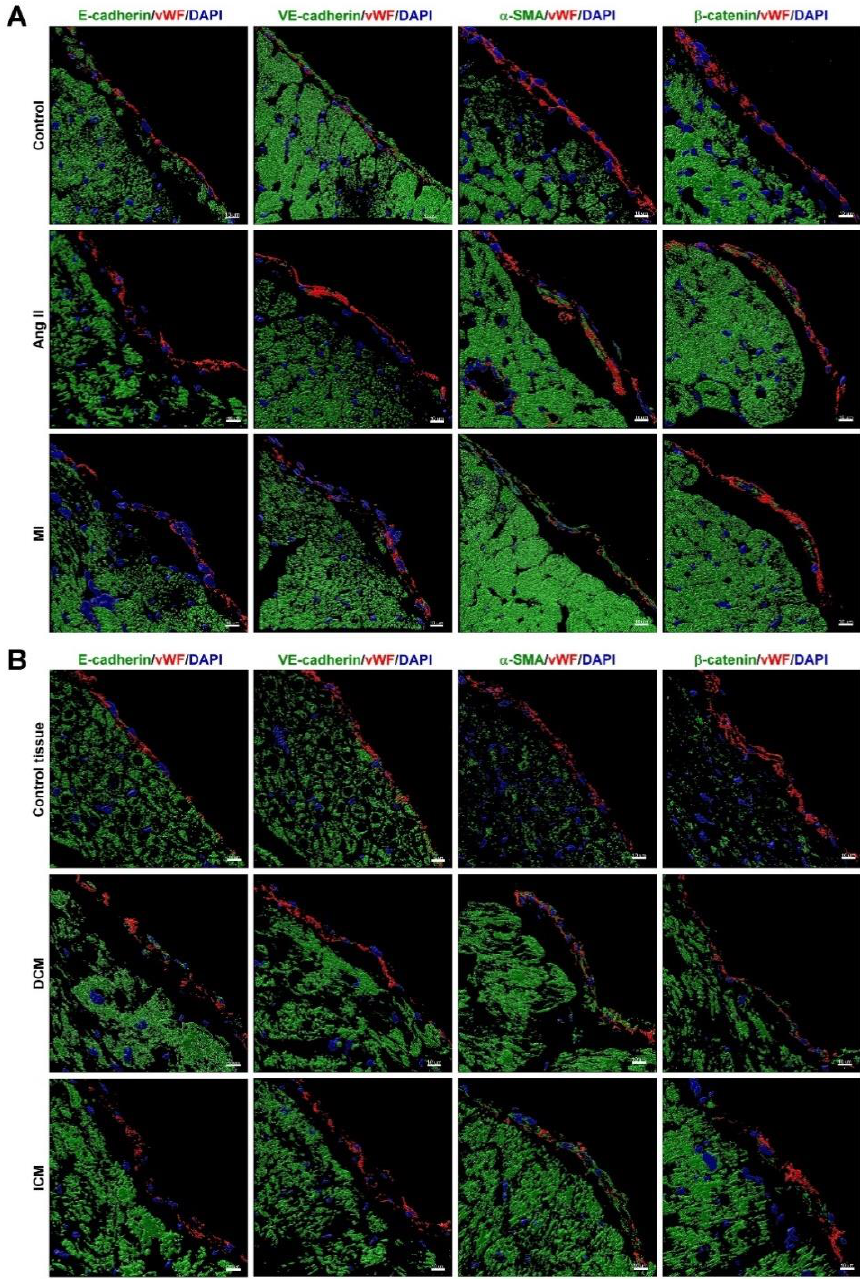
Figure 2. Endothelial-to-mesenchymal transition (EndMT) in the endocardium in HF. Immunostain- ing of vWF (endocardium marker, red), E-cadherin (green), VE-cadherin (green), α -SMA (green), β -catenin (green), and DAPI (DNA, blue) in the rat HF heart model ( A ) and human HF heart section ( B ). Scale bar: 10 μm.